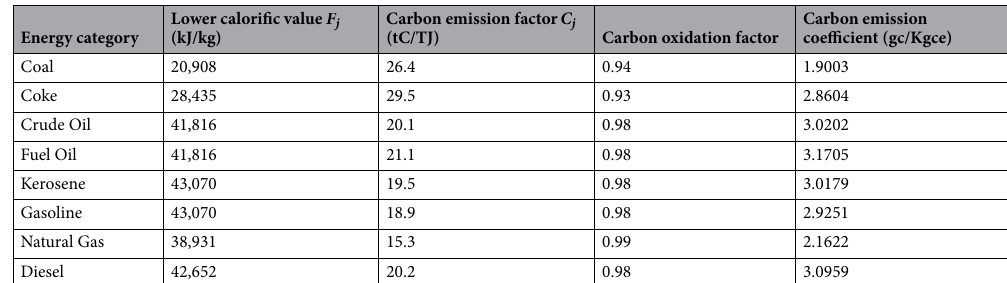
Table 1. Carbon emission coefficients of various energy. Data source: IPCC (2006) and Energy research institute of National Development and Reform Commission (2007).